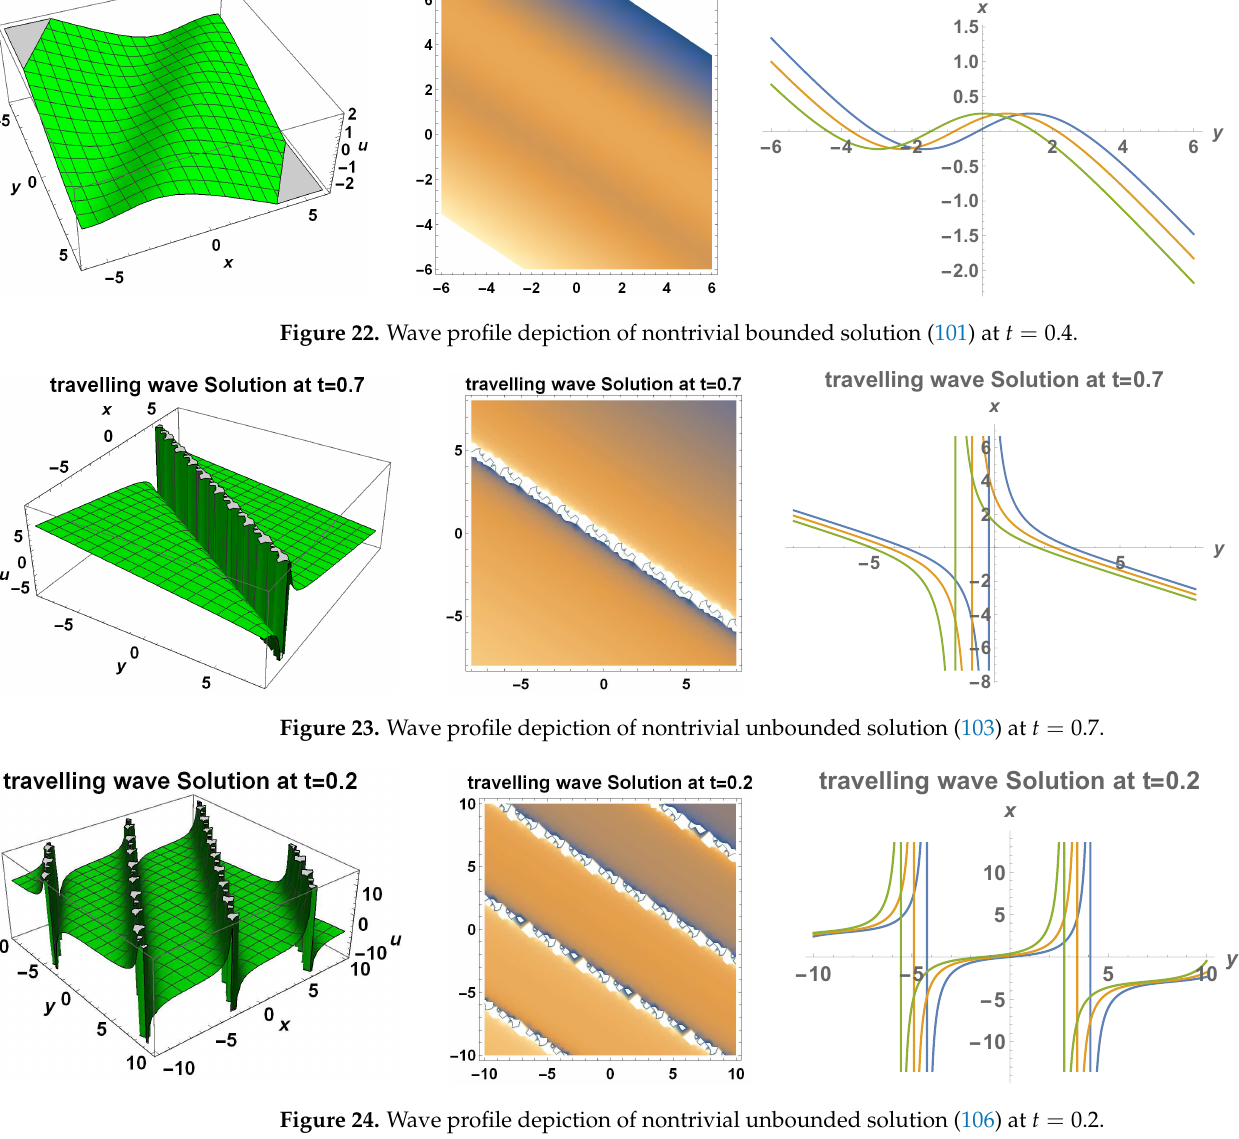
Figure 24. Wave profile depiction of nontrivial unbounded solution (106) at t =